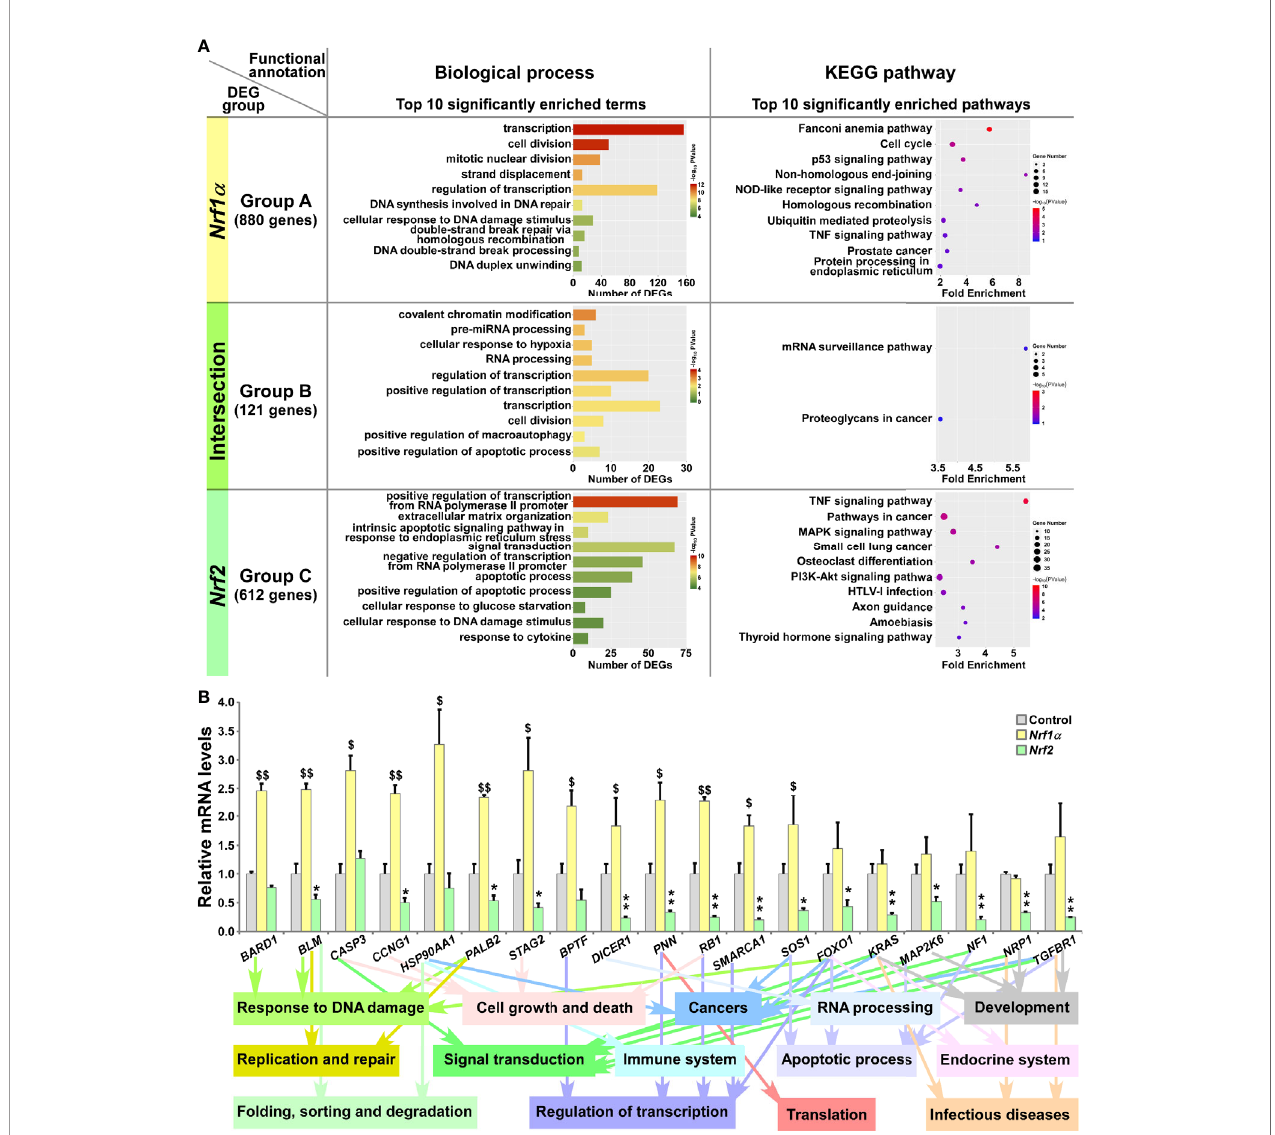
FIGURE 3 | Functional annotation of speci fi c or common DEGs in Nrf1 a and Nrf2 cells. (A) The top 10 of signi fi cant biological process terms and pathways enriched by DEGs in Groups A, B, and C were exhibited in histograms and scatterplots, respectively. (B) After Nrf1 a , Nrf2 and Control cell lines were incubated with 1 m g/ml Tet for 12 h, total RNAs were isolated and reversely transcribed into the fi rst strand of cDNA. Subsequently, the mRNA levels of DEGs that were associated with more functions, along with high expression levels and well signi fi cance in Groups A to C, were determined by quantitative real-time PCR analysis of Nrf1 a , Nrf2 and Control cell lines. The data are shown as mean ± SEM (n = 3 × 3, * p 0.05; ** p < 0.01; $ p < 0.05; $$ p < 0.01, when compared to the Control values